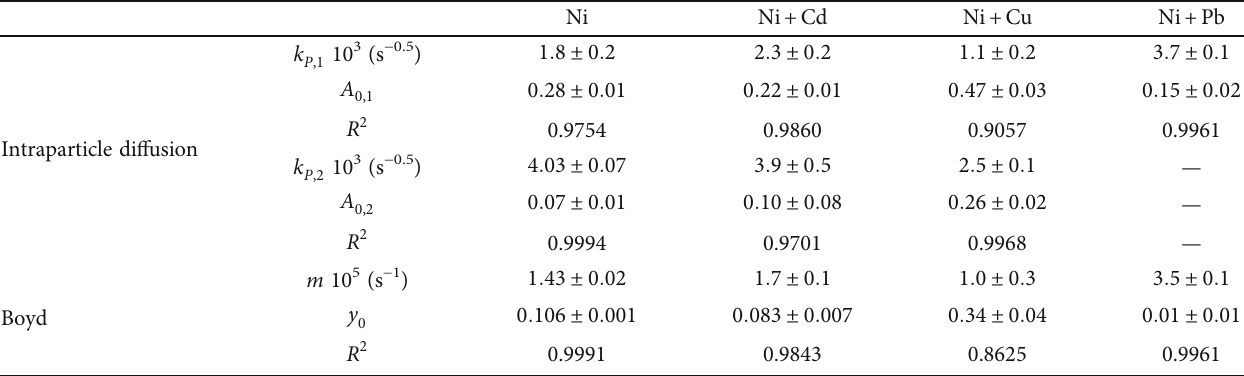
Table 6: Kinetic parameters obtained for intraparticle di ff usion and Boyd models for adsorption of Ni(II) in the absence and presence of other metal ions.